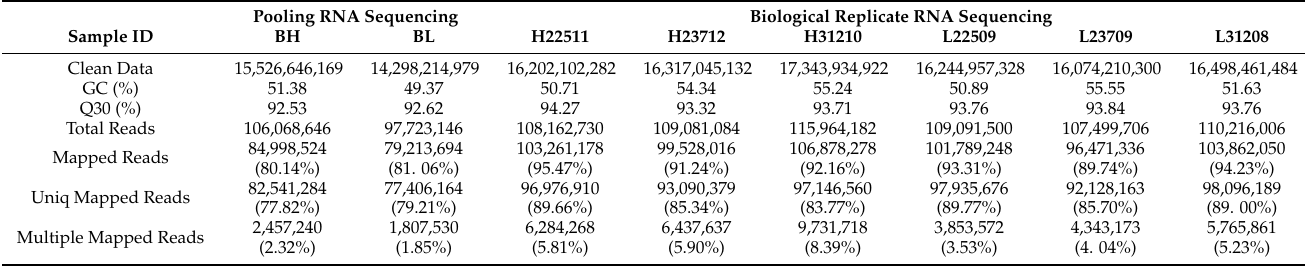
Table 1. Summary of reads after quality control and mapping to the reference genome. Pooling RNA